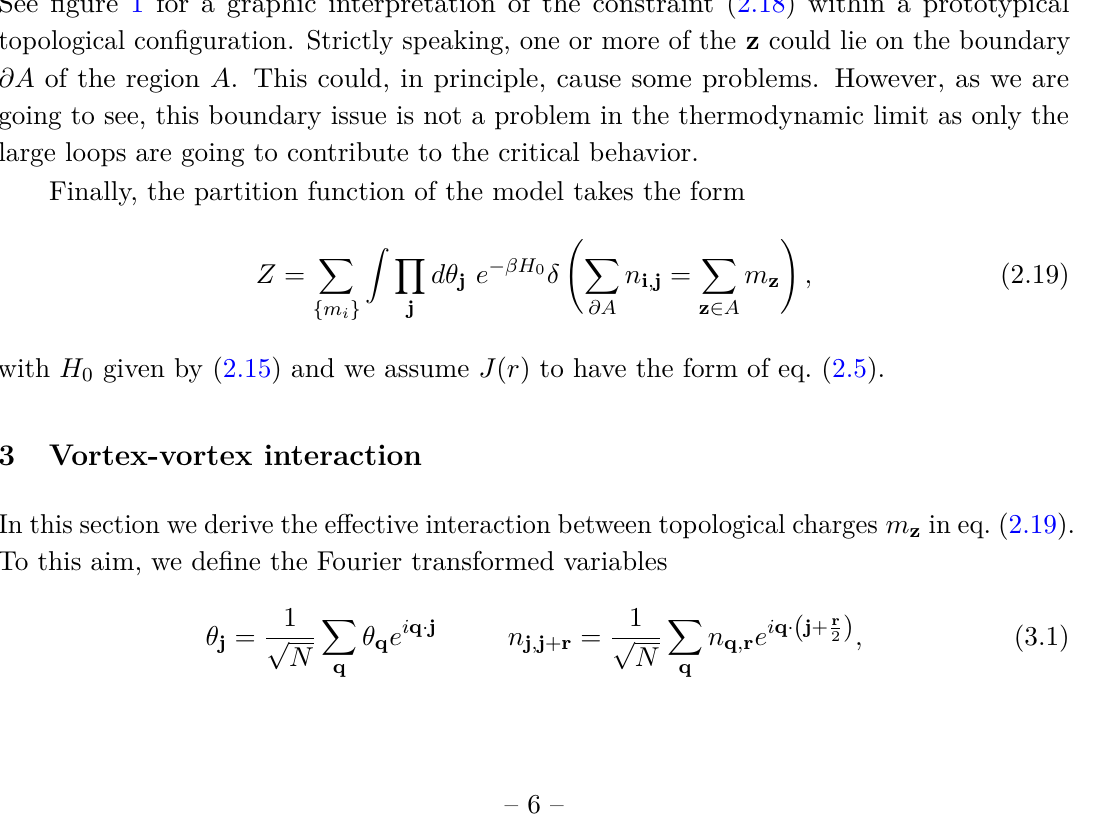
which is different i , j